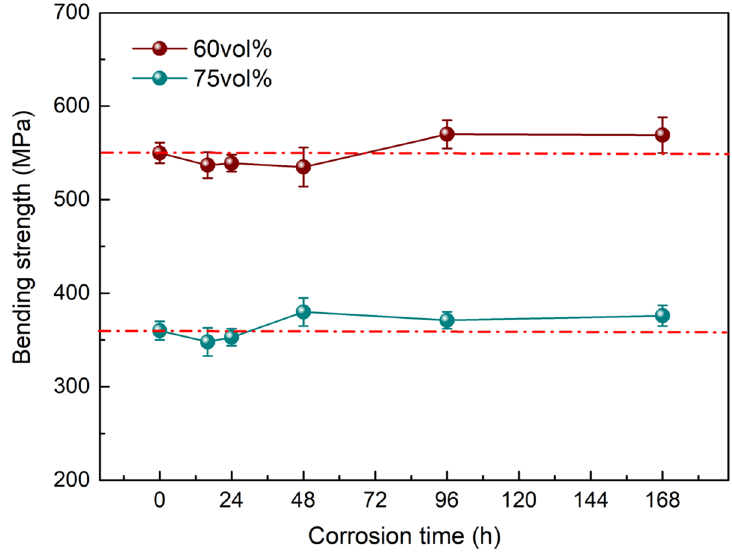
Figure 6. Bending strength of Diamond / Cu composites during neutral salt spray test.